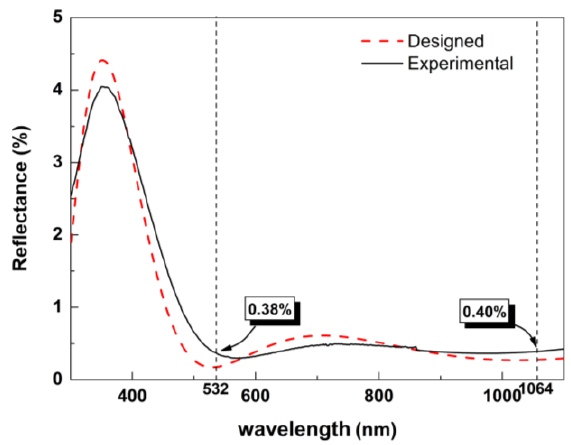
Figure 6. Reflectance spectra of fabricated dual-layer coating system and optimized theoretical design.